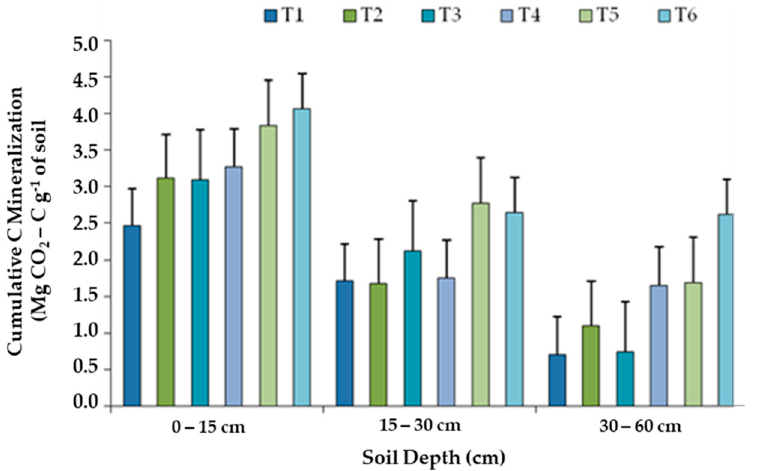
Figure 5. Cumulative C mineralization (C min ) (mg/g soil) at 0–15, 15–30 and 30–60 cm soil depths, as influenced by long-term organic manure. Note: T1, control without fertilization; T2, farmyard ma- nure (FYM); T3, green manure (GM); T4, GM + biofertilizers (BF); T5, FYM +GM; T6, FYM + GM + BF.